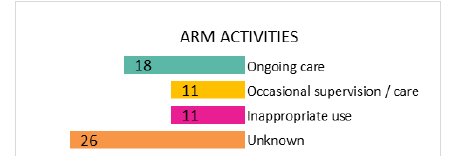
Figure 3. Sites distribution according to the type of activities